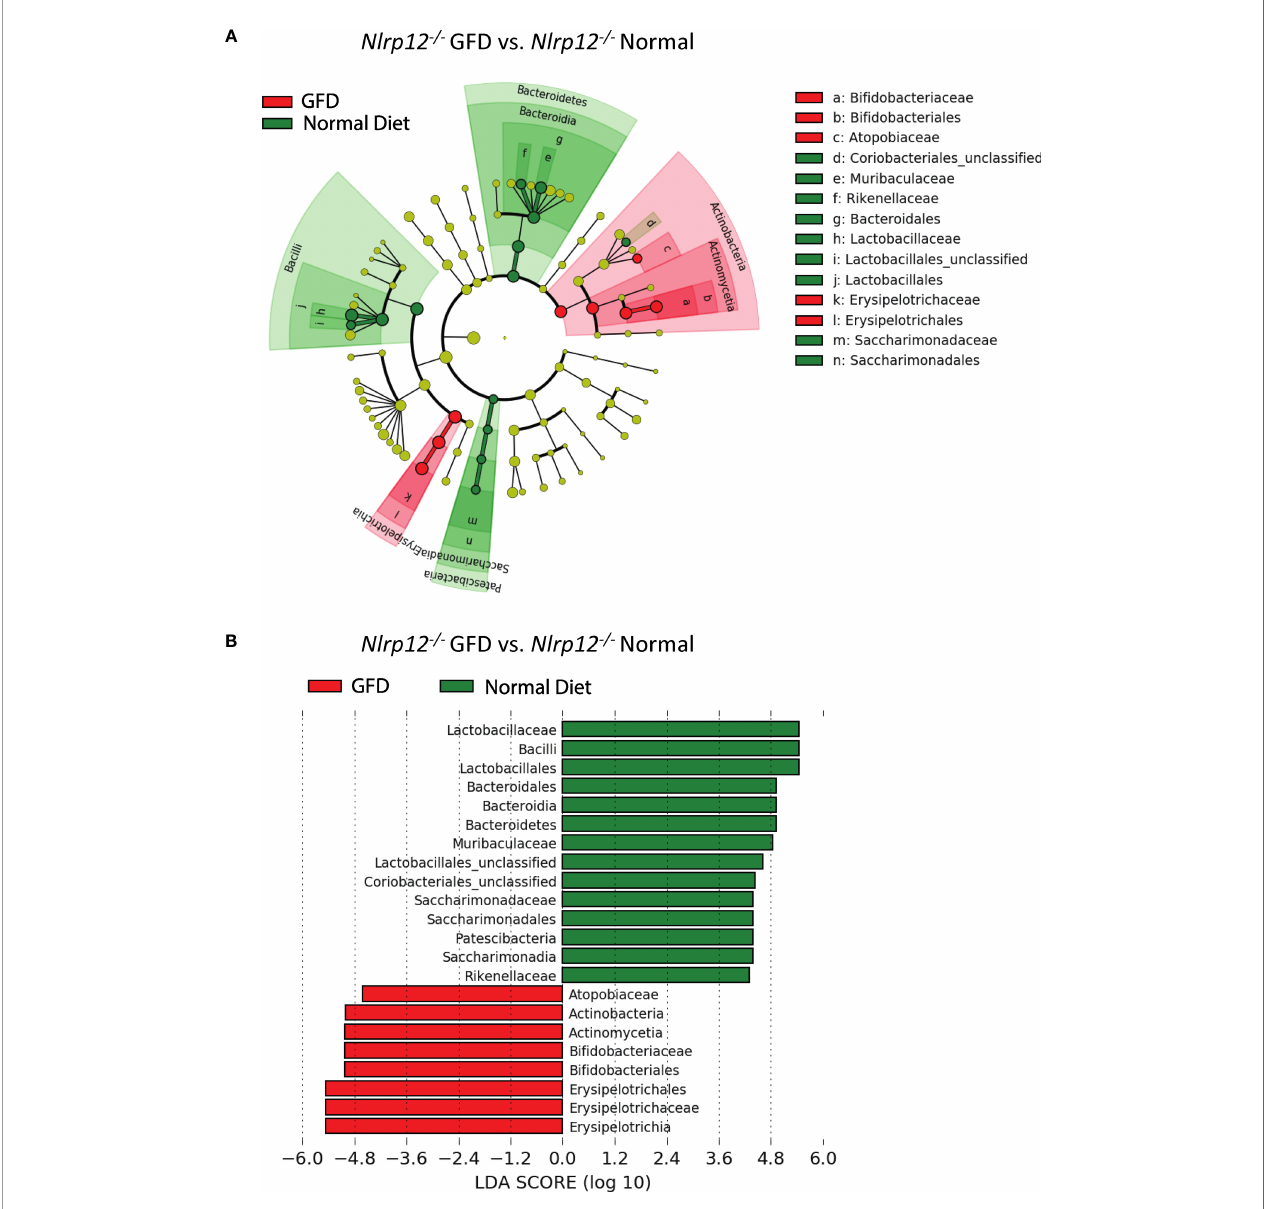
FIGURE 7 | The Effects of GFD on the Microbiome of NLRP12-de fi cient Mice. (A) Cladogram displaying differential bacterial abundance in NLRP12 -/- mice fed GFD (red) and normal diet (green). (B) LEfSe differential analysis displaying bacterial abundance in NLRP12 -/- mice fed GFD (red) and normal diet (green) reveals that signi fi cant differences exist between the microbial populations. The graph was generated using the LEfSe program. GFD (red), n = 7 ; normal diet (green), n =